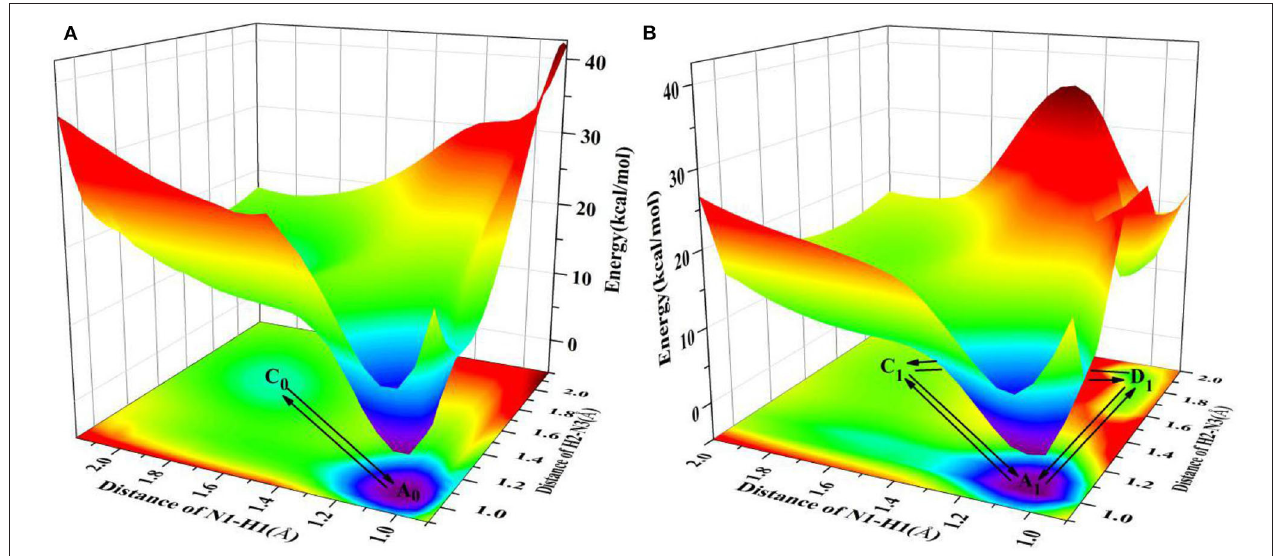
FIGURE 1 | PESs on both S 0 and S 1 states of ZP as the functions of N1-H1 and H2-N3 length in the gas phase. (A) S 0 state PES; (B) S 1 state PES.